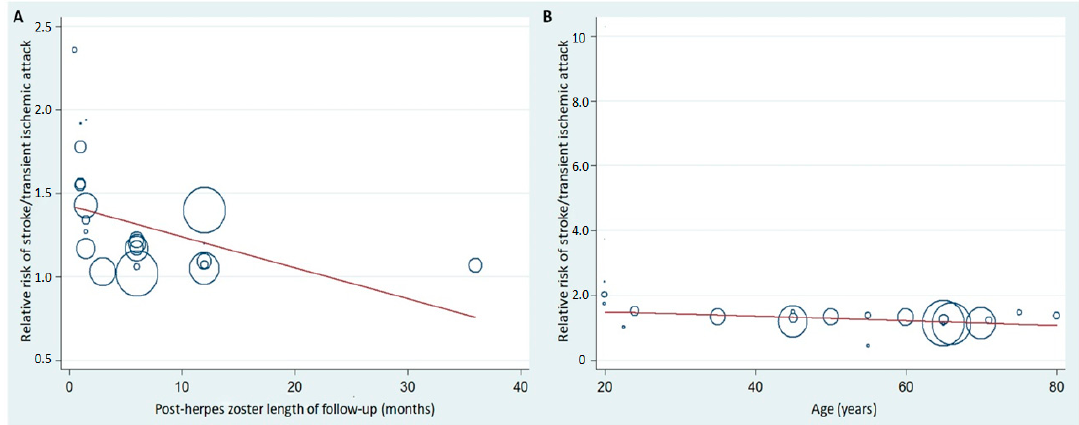
Figure 3. Meta-regression of the post-HZ length of follow-up ( A ) or age of the subjects ( B ) and relative Figure 3. Meta ‐ regression of the post ‐ HZ length of follow ‐ up ( A ) or age of the subjects ( B ) and relative risk of stroke / TIA in post-HZ patients. HZ, herpes risk of stroke/TIA in post ‐ HZ patients. HZ, herpes zoster.